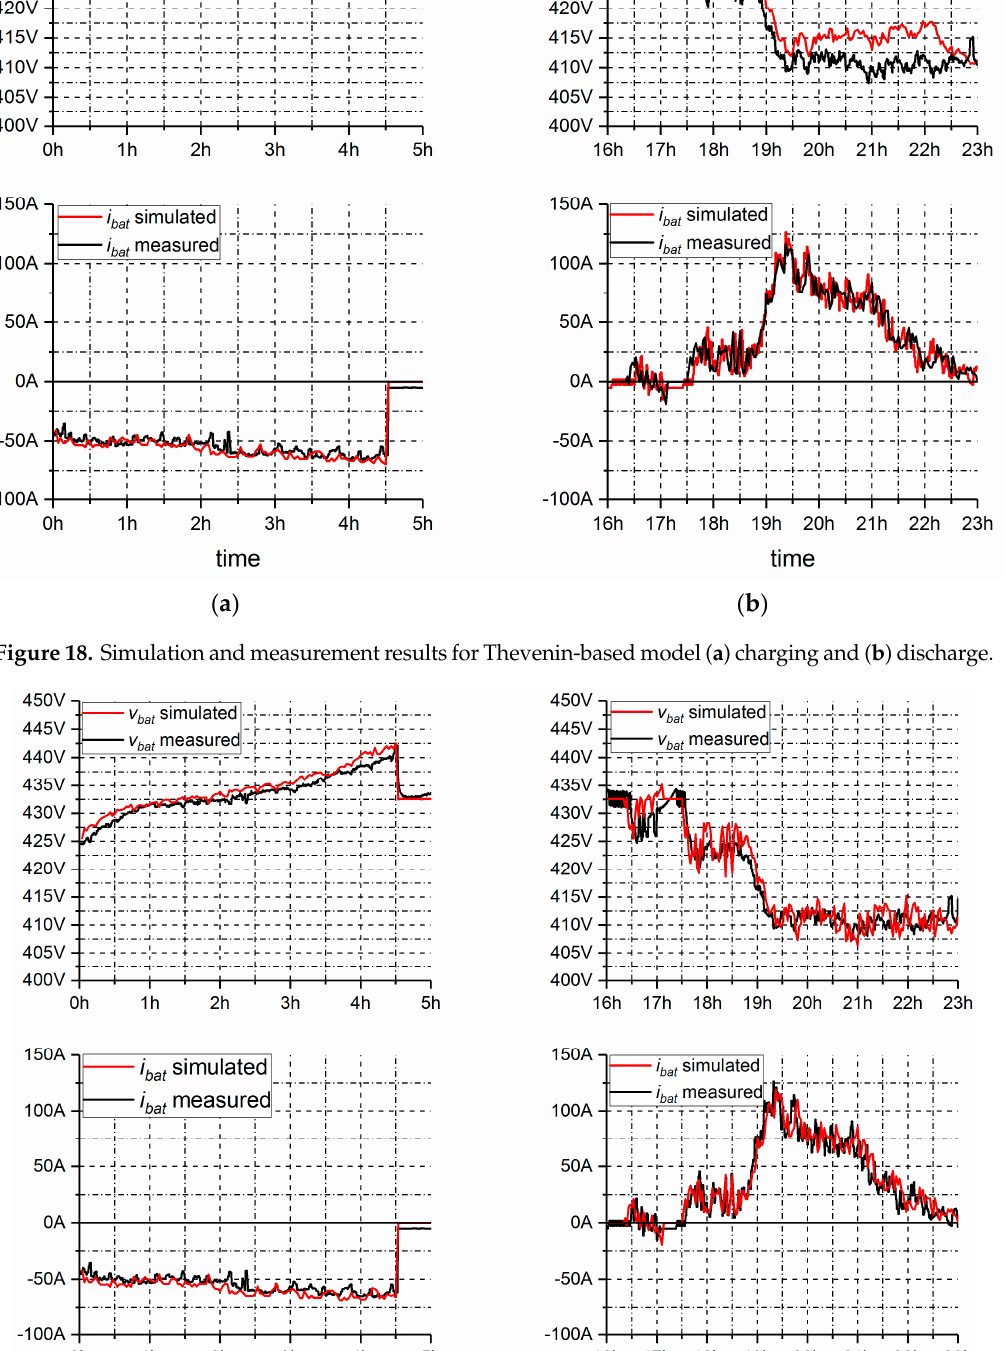
Figure 19. Simulation and measurement results for Rint model ( a ) charging and ( b ) discharge.